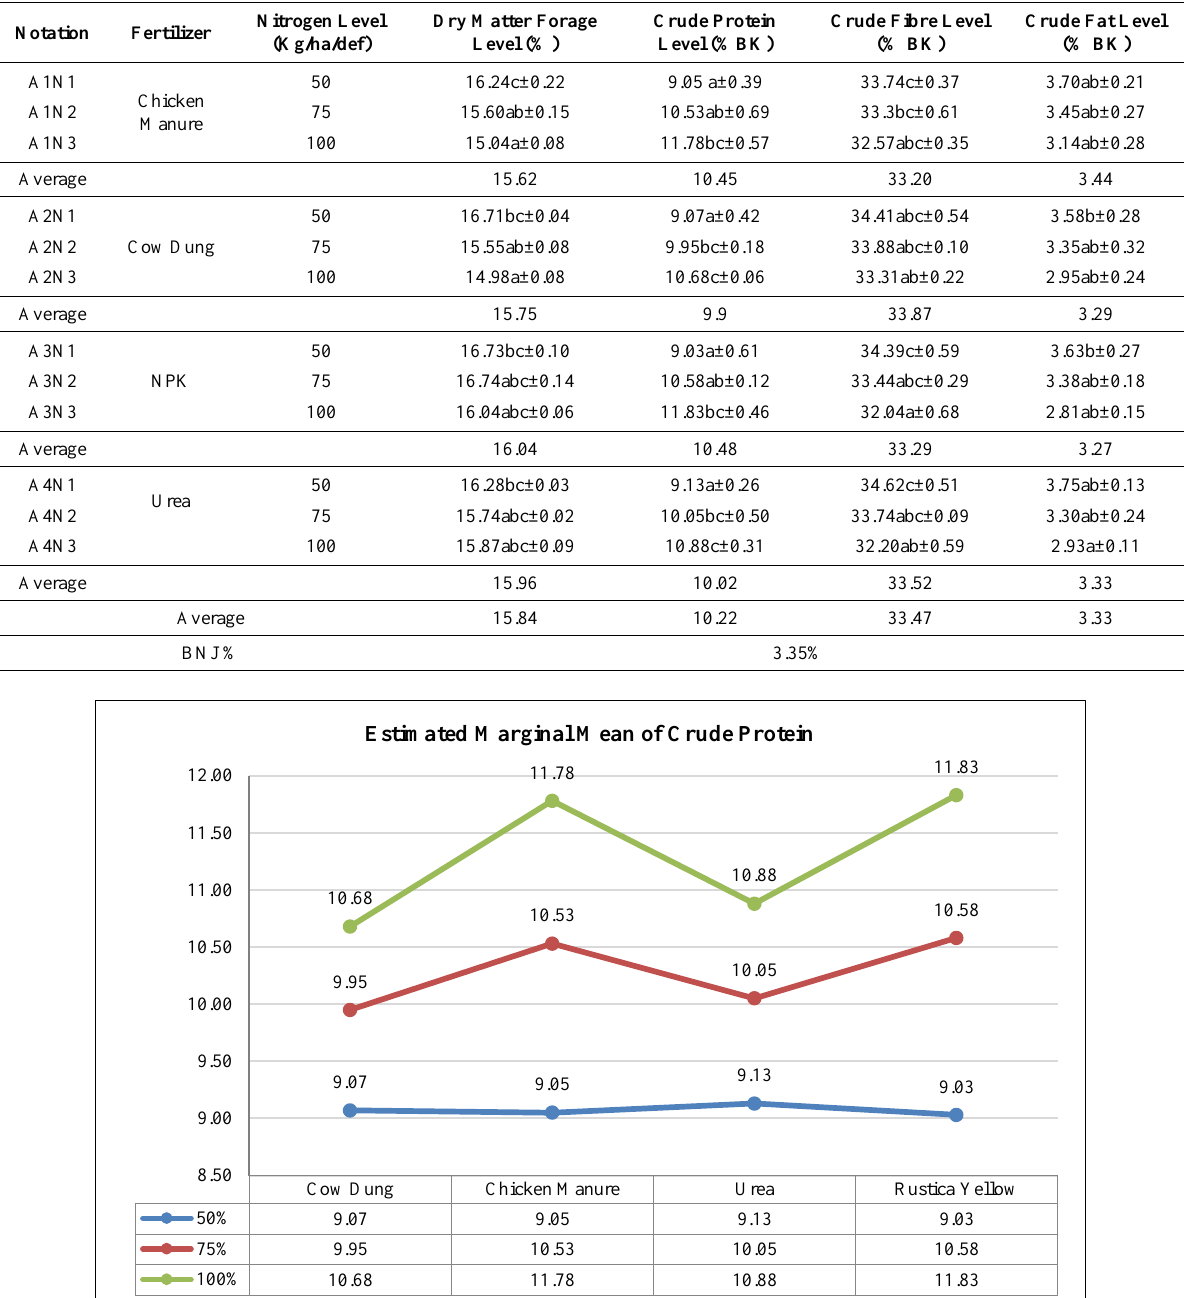
Table 3. Average results of the research